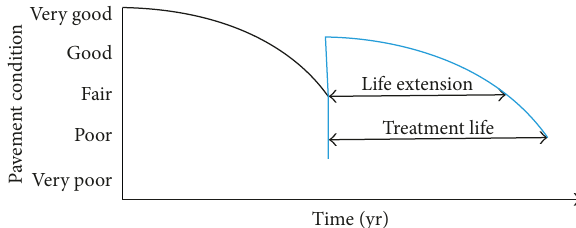
Figure 1: Treatment life and life